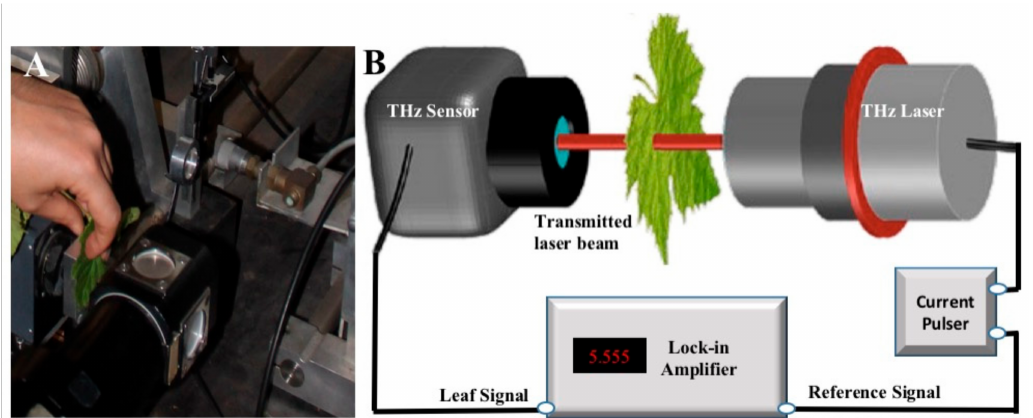
Figure 1. ( A ) THz leaf measurement method using a current pulser driving a THz cryo-cooled quantum cascade laser (QCL) to generate 2.55 THz laser radiation. ( B ) THz transmission measurement